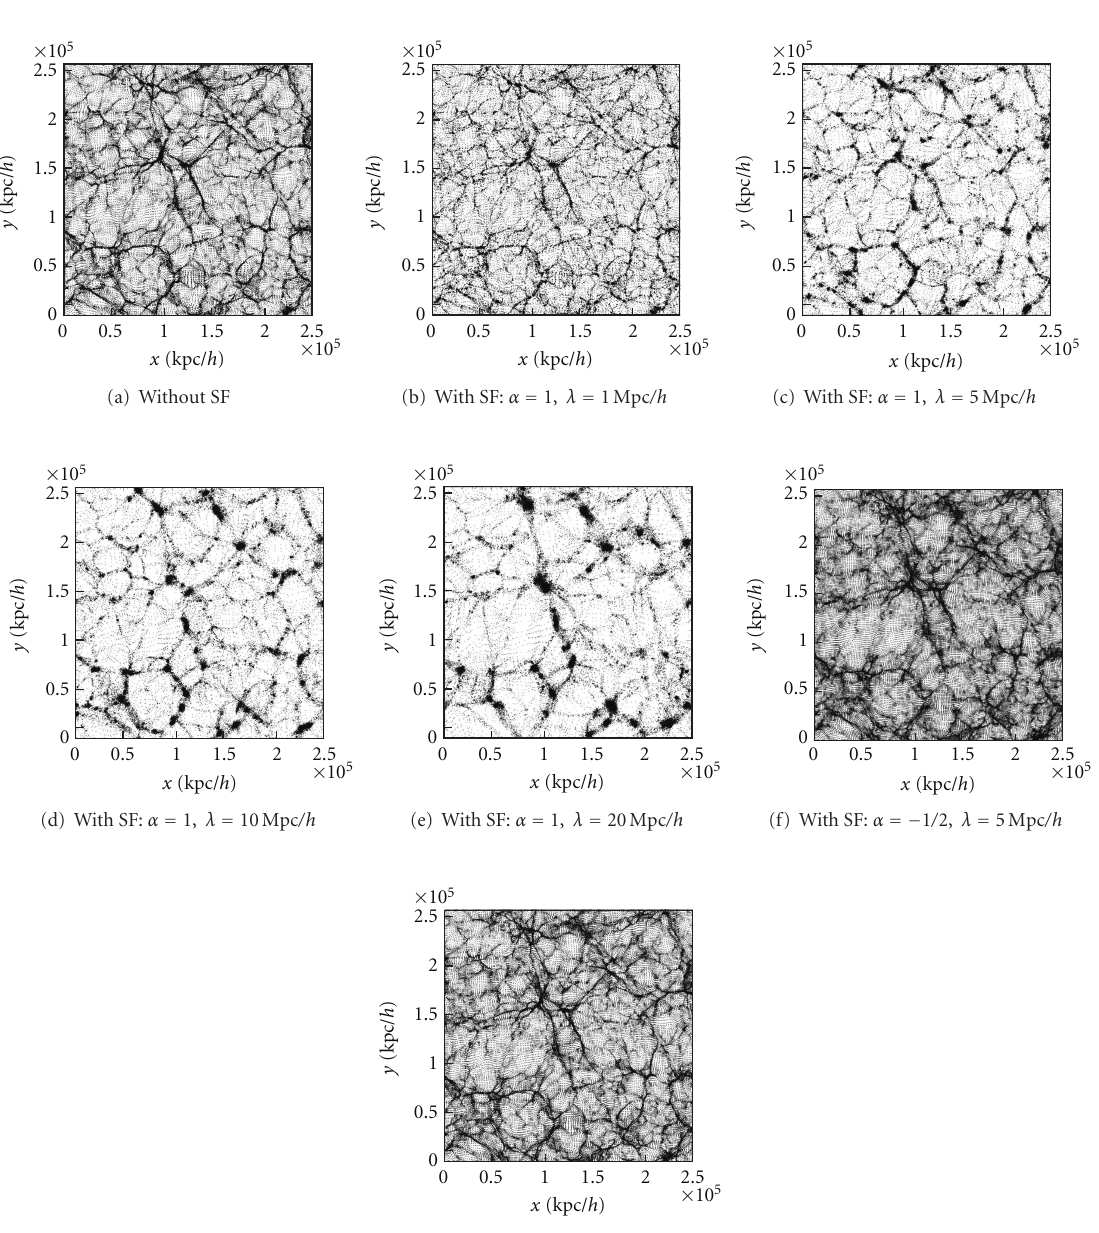
Figure 3: (a) LSS formation process without the SF contribution. (b) and (c) LSS formation process with the SF contribution. (b) α = 1 and λ = 1Mpc /h . (c) α = 1 and λ = 5Mpc /h . (d) and (e) LSS formation process with the SF contribution. (d) α = 1 and λ = 10Mpc /h . (e) α = 1 and λ = 20Mpc /h . (f) and (g) LSS formation process with the SF contribution. (f) α = − 1 / 2 and λ = 5Mpc /h . (g) α = − 1 / 4 and λ = 5Mpc /h